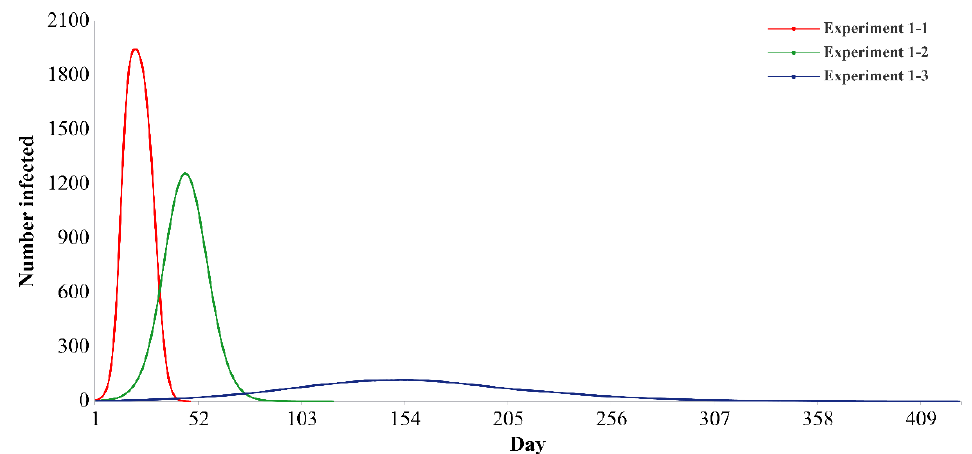
Figure 3. Infection curves of basic experiments based on three kinds of going-out needs. Note: Experiments 1-1 to 1-3 indicate that the three types of policies are all in strict, moderate and loose states, respectively. Specific parameter values are presented in Table 2.